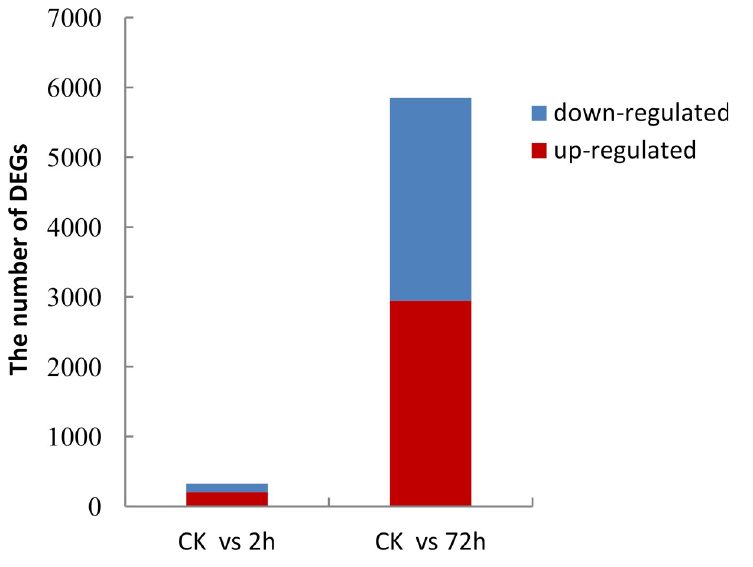
Fig 5. DEGs in Manila grass leaves under cold stress.